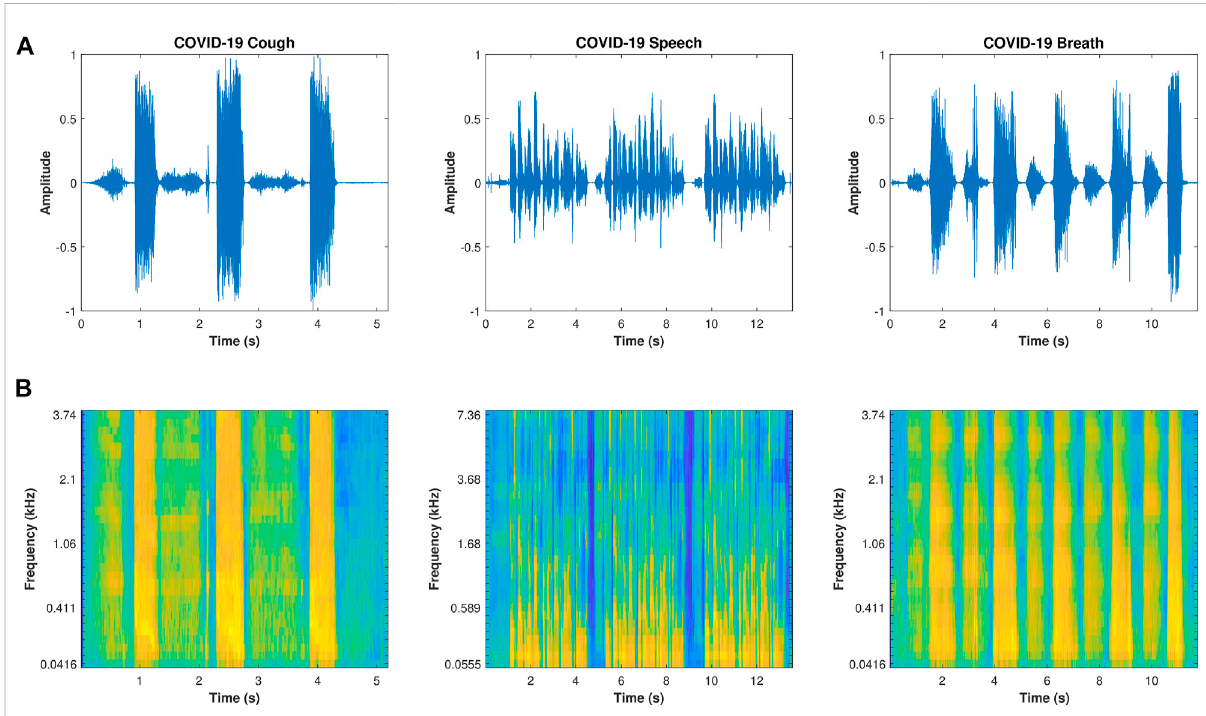
FIGURE 2 Cough, speech, and breath signal representation. (A) shows the signals in the time domain; (B) shows the time – frequency Mel spectrogram